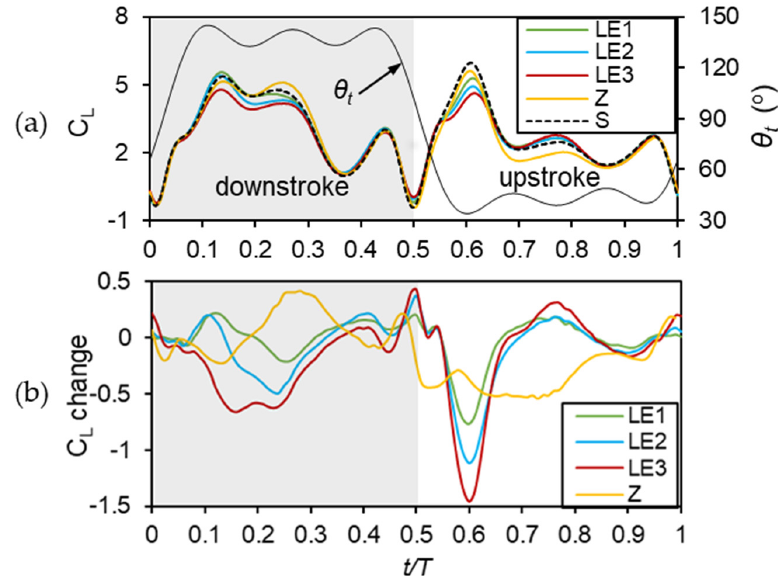
Figure 10. Comparison of lift coe ffi cient: ( a ) the time courses of lift coe ffi cients (C L ) and ( b ) the changes in the lift coe ffi cients (C L change) of the Z, LE1, LE2, and LE3 wings, compared to those of the S wing, at r = 0.75 R .